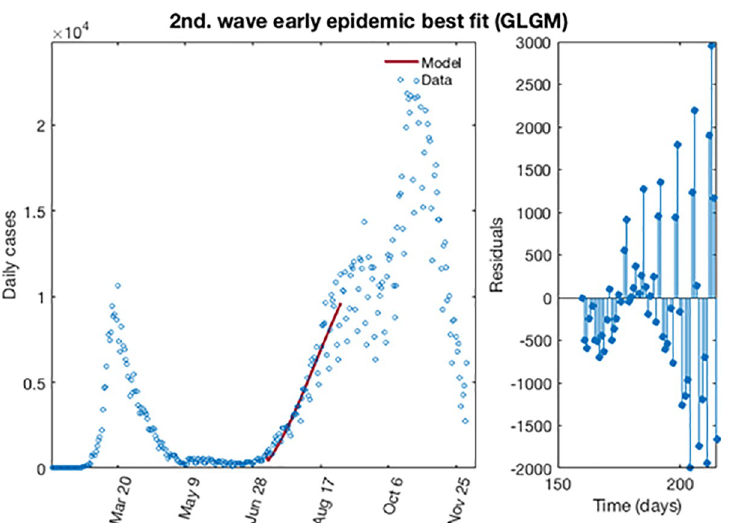
The residuals are displayed in the right panel.